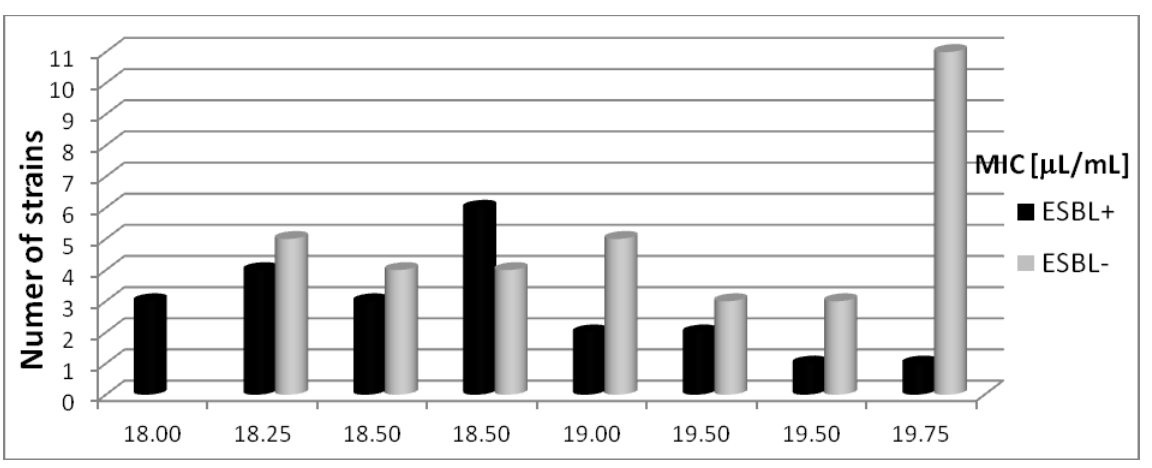
Figure 4. The susceptibility of Escherichia coli (ESBL+) and (ESBL − ) strains to rosemary